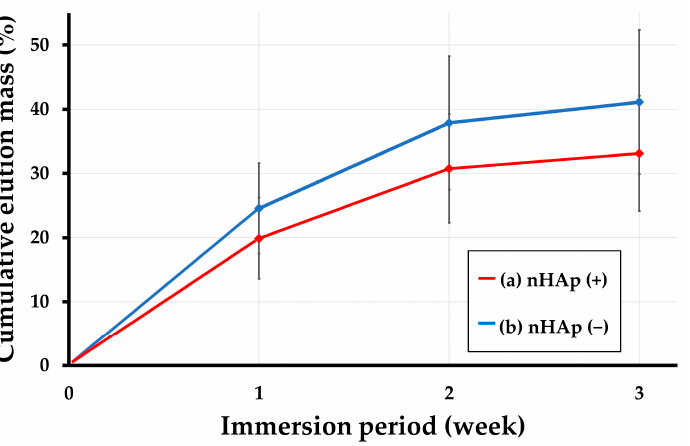
Figure 4. Hydrolytic degradation/protein release test results of two constructs including ( a ) nano-hy- droxyapatite (nHAp) (+) constructs (i.e., cHLA/cAG/nHAp/bovine serum albumin (BSA)) and ( b ) nHAp ( − ) constructs (cHLA/cAG/BSA).